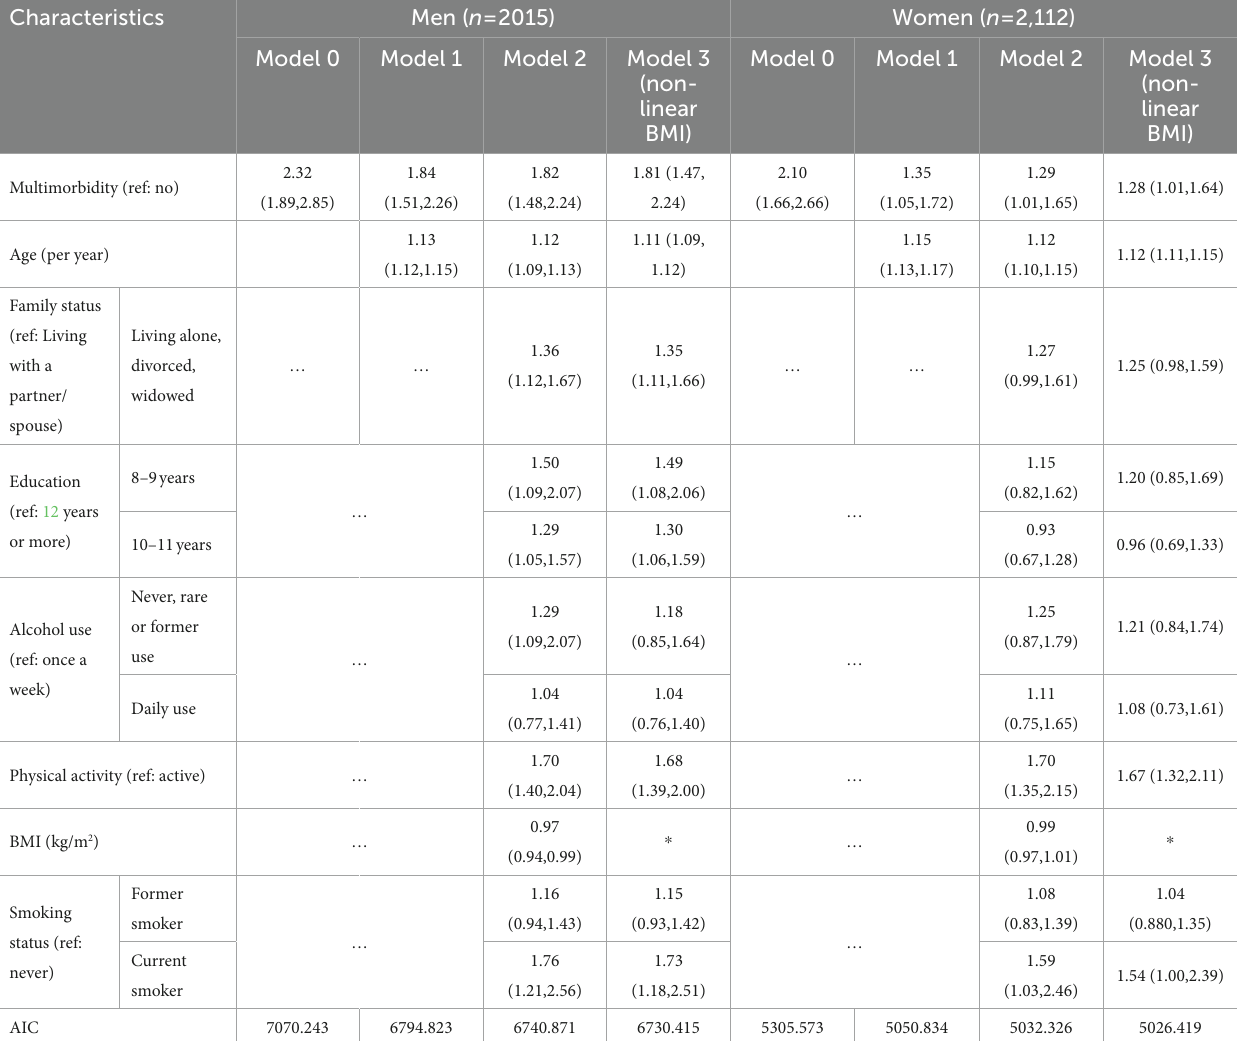
TABLE 2 Multivariate adjusted association of MM and all-cause mortality for men and women.